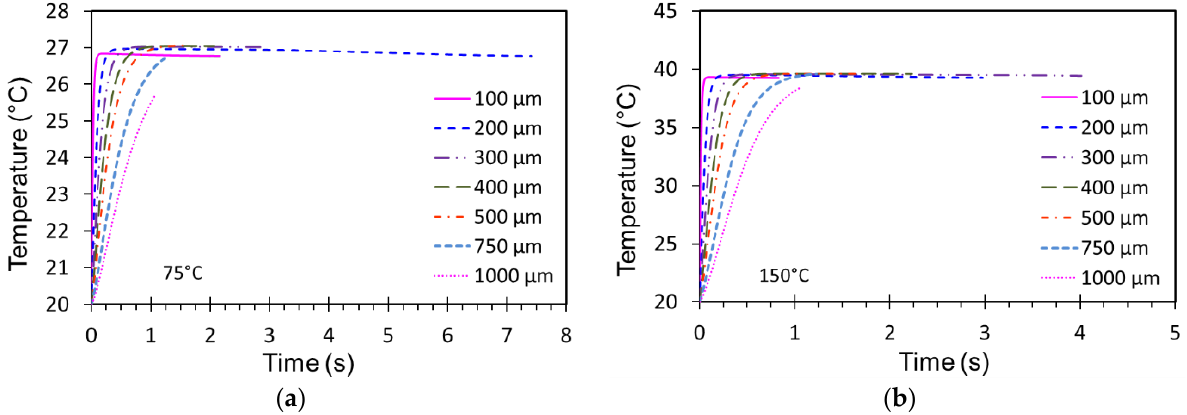
Figure 3. The effect of the initial size of diameter on the temperature trajectories of droplets; ( a ) condition 1 (75 °C); and ( b ) condition 2 (150 °C).